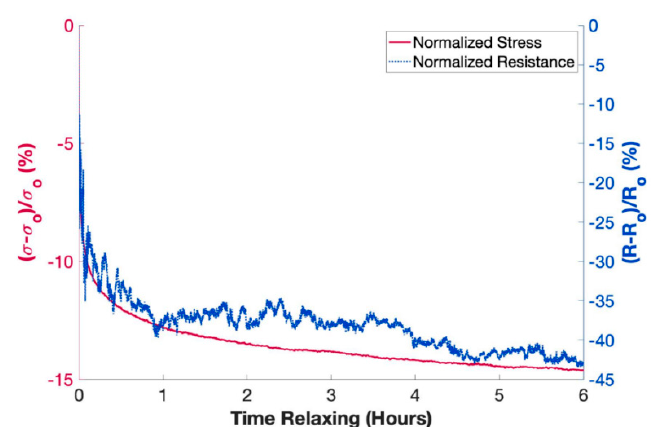
Figure 9. Piezoresistive change during stress relaxation behavior of a 2.5 wt. % porous nanocomposite held at 10% compressive strain for 6 h.